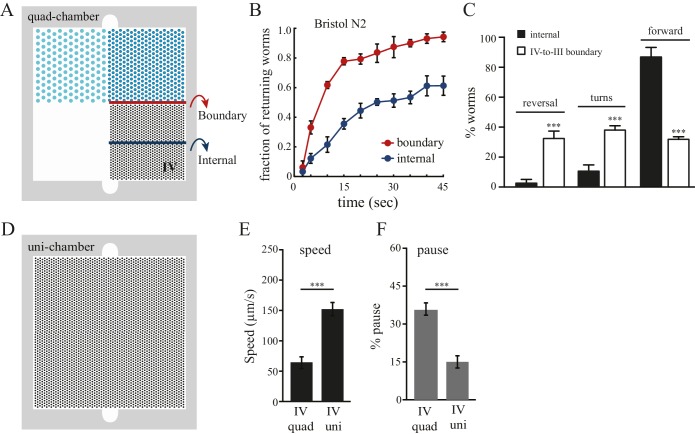
Boundary experience impacts C. elegans spatial pattern selectivity.Crossing the boundary from pattern IV to pattern III stimulates worms to return to pattern IV. (A) The red line indicates the boundary between patterns IV and III, and the blue line serves as a reference line in the middle of pattern IV. (B) The fraction of worms returning to pattern IV at indicated time points. Time zero indicates the moment that worms cross the red line (from pattern IV to III) or the blue line. Data were collected between 55–65 min after the worms were loaded into the chambers. n = 6. (C) Worms exhibit increased reversal and turning rates when they cross the pattern IV-to-III boundary. n = 6. (D) The design of the uniform chamber (uni-chamber). This chamber has only one pillar array pattern, which is identical to pattern IV in the quad-chamber. (E–F) Worms show different locomotion properties within pattern IV depending on the presence of absence of alternative surrounding patterns. The speed of moving (µm/sec) and the pause rates (%) were quantified from worms within pattern IV in either the quad-chamber or the uni-chamber. The number of independent repeats, n = 6; ***p<0.001; Student’s t test. Error bars denote s.e.m.